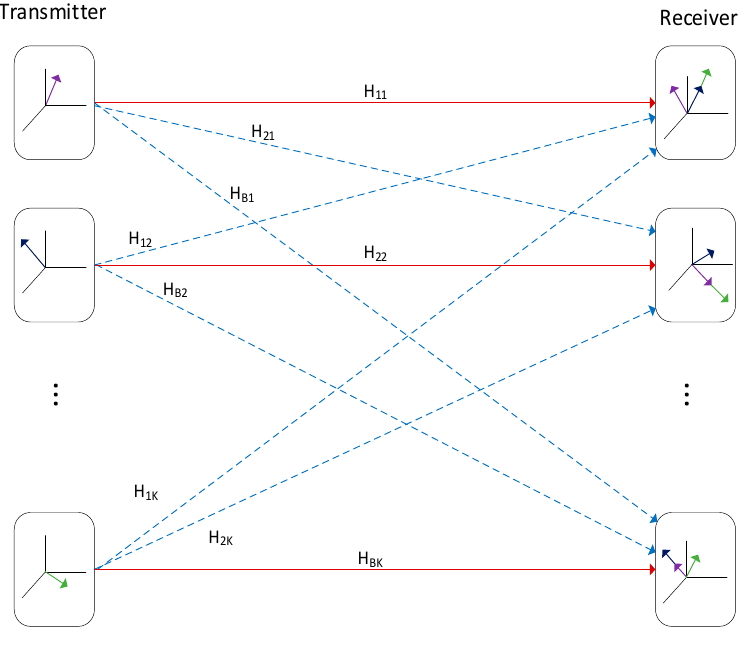
Figure 1. Illustration of the interference alignment (IA) principle.